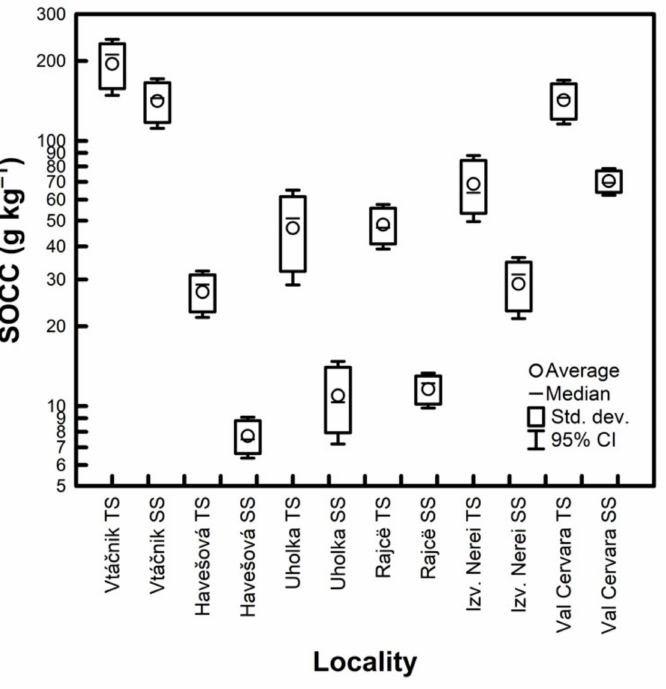
Figure 3. Average and median soil organic carbon concentration (SOCC) in both topsoil (TS: 0.00–0.20 m) and subsoil (SS: 0.20–0.80 m) for each locality. The vertical axis is in a logarith- mic scale. Table 4. Average soil organic carbon concentration (SOCC) for each locality and plot, calculated from 24 values in each soil profile. The coefficient of variation (CV) was calculated from plot averages in each locality. Abbreviations: Avg.—average.